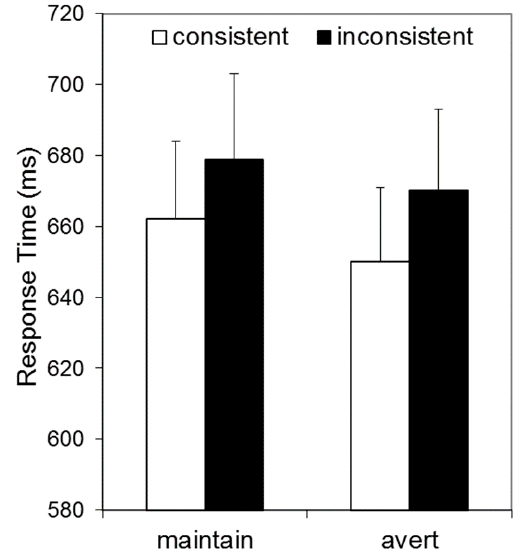
Figure 3. Data from Experiment 2. Response times in an adapted Samson avatar task as a function of whether the number of dots visible to the avatar and participant were consistent, and whether avatar gaze was maintained or averted.